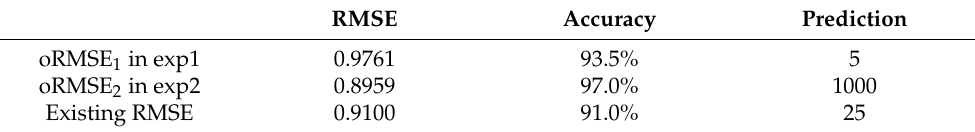
Table 7. Comparison table of oRMSE obtained in our